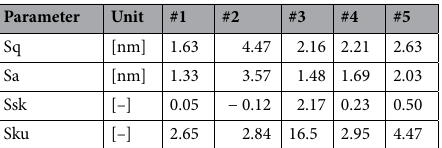
Table 3. Relevant roughness and height parameters for the analysed samples from AFM